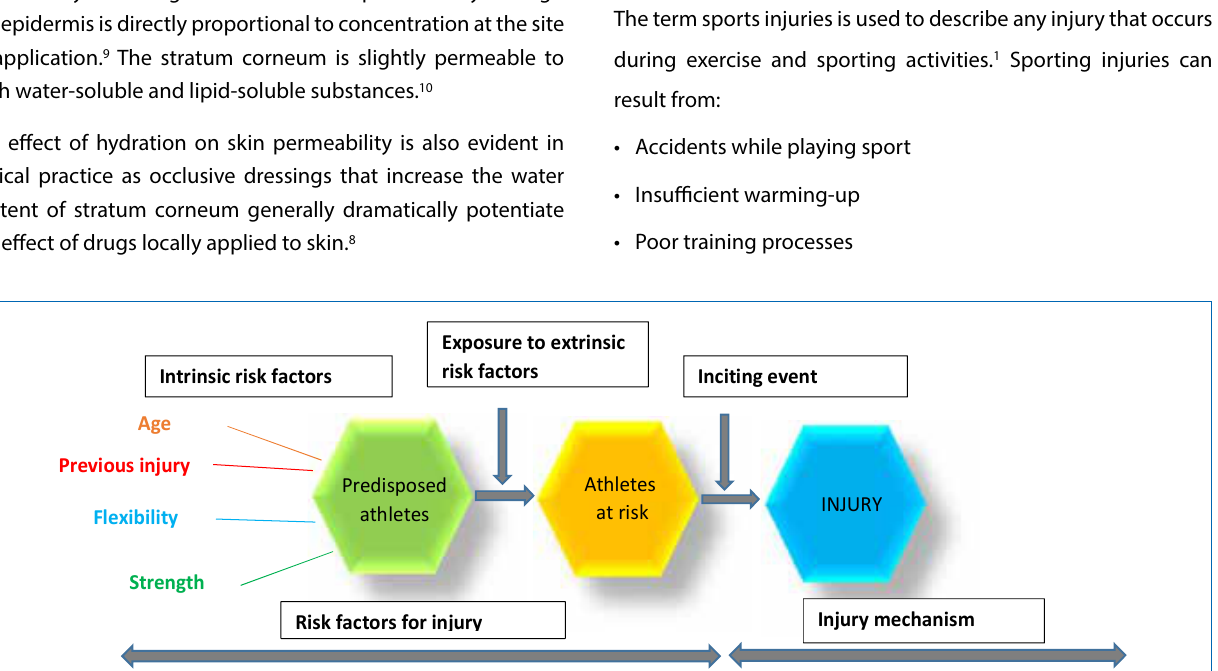
Figure 3: Risk factors for sport injuries 5 Classification of sports injuries